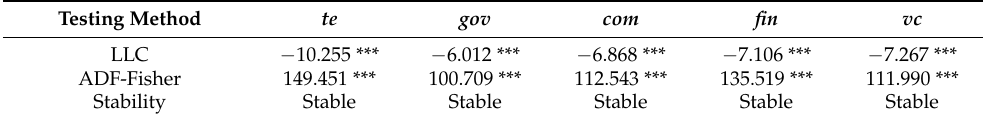
Table 3. Panel unit root test results.